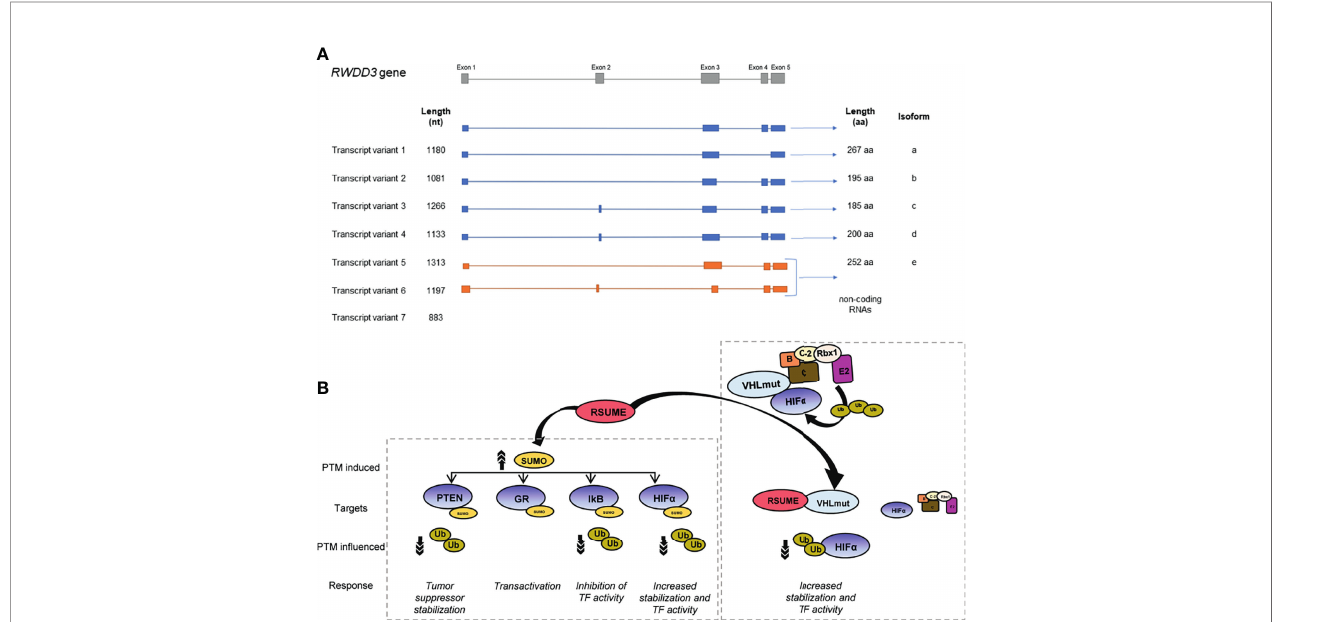
FIGURE 1 | Scheme of human RWDD3 transcript variants and RSUME targeted proteins. (A) Seven transcript variants of RWDD3 human gene, of which fi ve are translated into protein and two of these proteins are the best characterized proteoforms, RSUME-195 and RSUME-267. (B) RSUME interacts and enhances SUMOylation of targeted proteins (PTEN, GR, IkB and HIF a ), affecting other PTMs, occurring in the same protein. The reduction of ubiquitination enhances activity of transcription factors (TFs) such as HIF a or transcription factor regulators (IkB, PTEN). RSUME promotes HIF a accumulation and activity by another mechanism independent of SUMOylation: the interaction of RSUME with VHL (the HIF a ubiquitin E3 ligase that promotes its degradation in normoxia) decreases VHL – HIF a binding and consequently HIF a